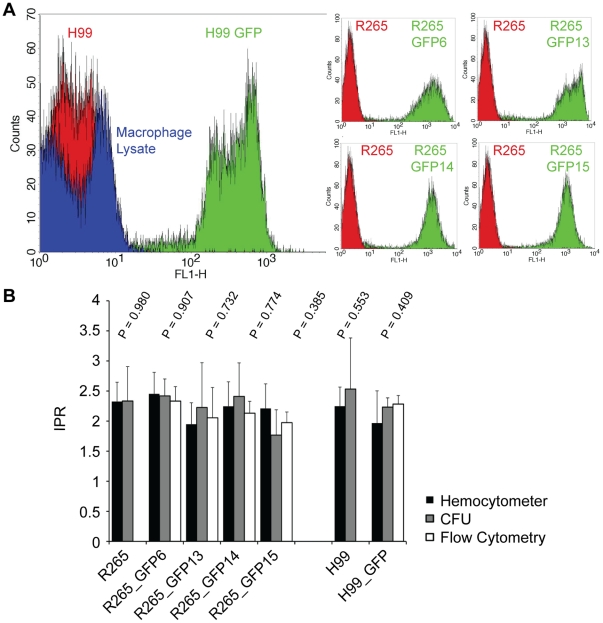
Automated counting of intracellular Cryptococcus proliferation within macrophages.(A) GFP-tagged strains were first analysed for their expression profile. All GFP-expressing strains are clearly discernable from GFP-negative cryptococci or cell debris. (B) Replicate samples were used for quantifying intracellular yeast cell numbers after macrophage infection via haemocytometer (black bars), CFU count (grey bars) or flow cytometry (white bars). For all of the strains, there was no statistically significant difference between any of the three counting methods. Data are presented as means with 2 times standard error from at least three independent repeats.